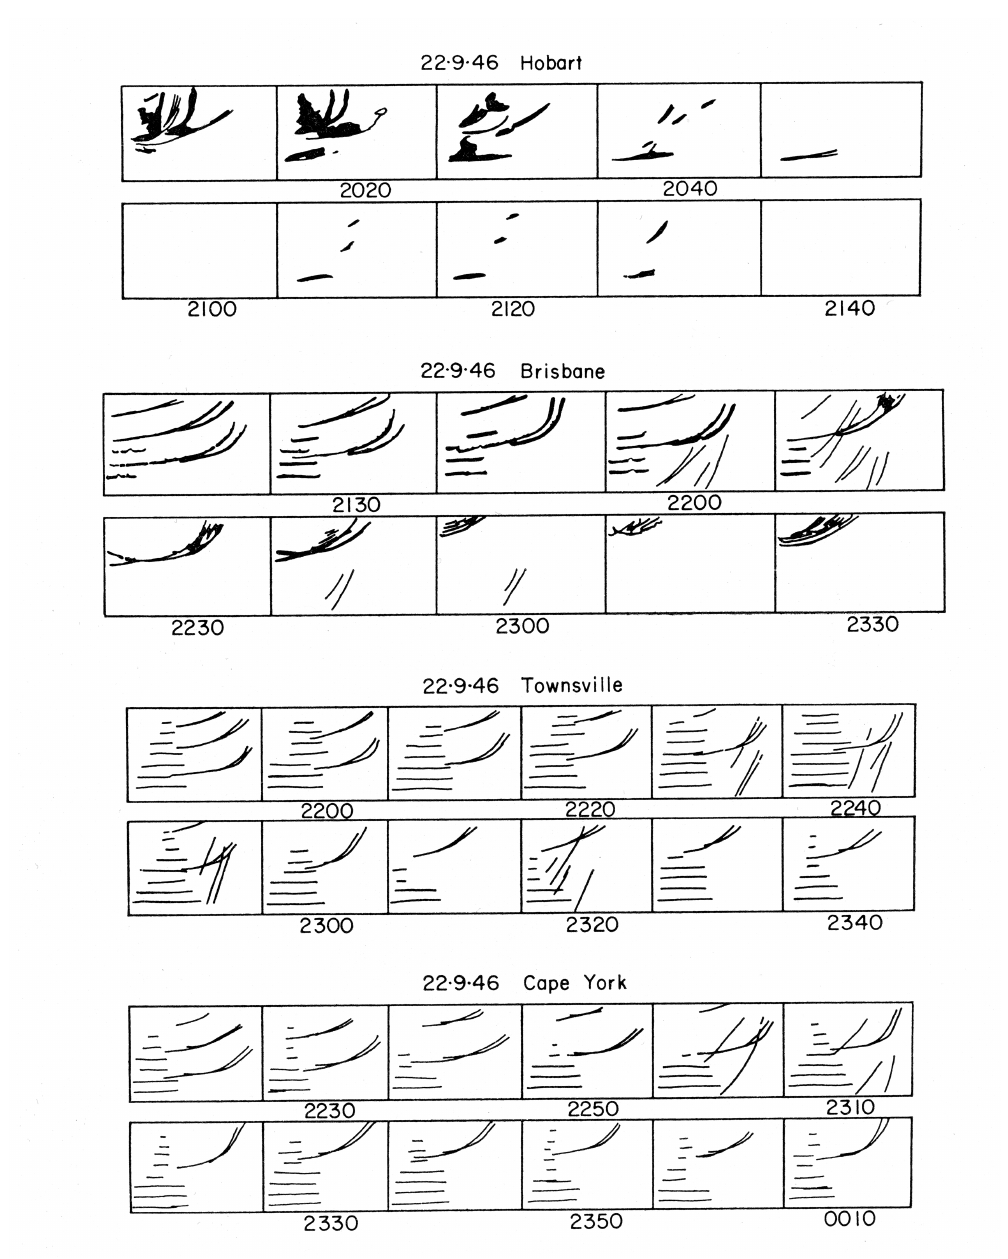
Fig. 6. A reproduction of Fig. 10 of Bowman (1965) which shows the propagation of a LS-TID at 4 Australian stations on September 22, 1946. Ionogram tracings are used, and a speed of 396ms − 1 is indicated.